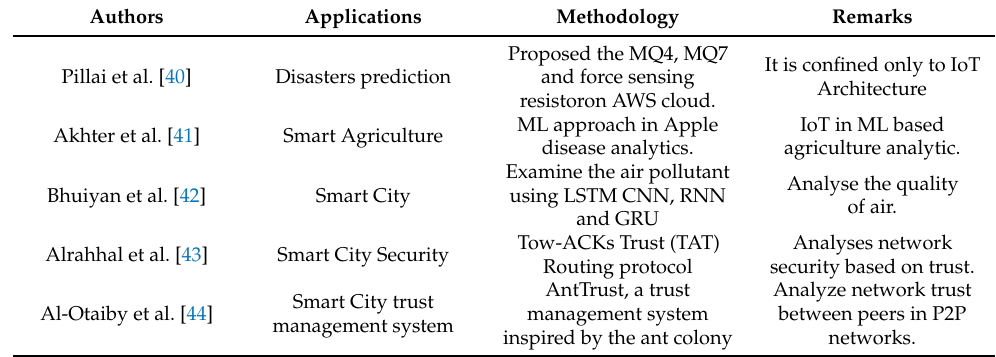
Table 2. State of the